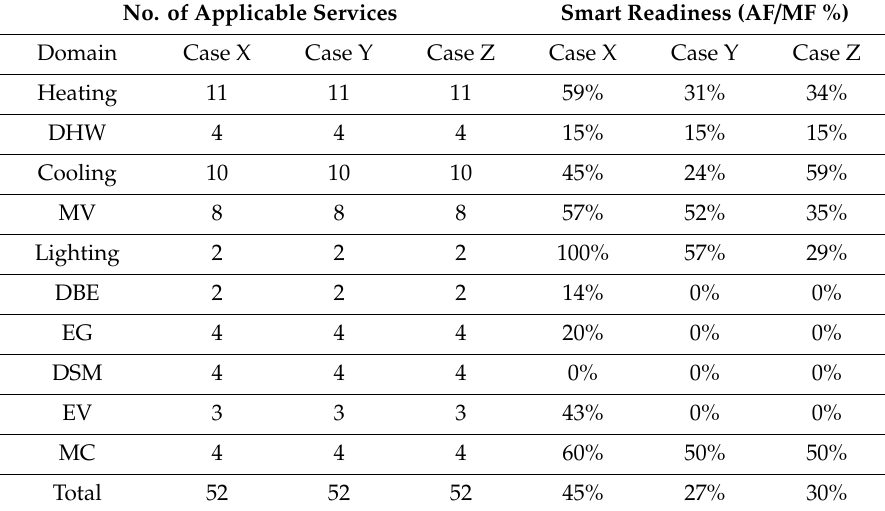
Table 16. The resulting smart readiness after triage process